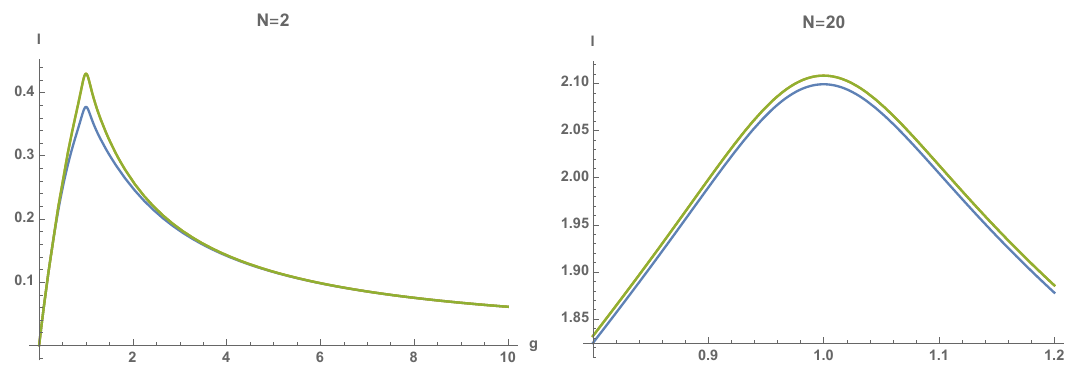
Figure 7. In the above (cid:12)gures the blue and green lines respectively denote the modular invariant interpolating functions for the cusp anomalous dimension ((cid:0) cusp ( (cid:21) )) with zero and non-zero value of the non-planar term (cid:0) np . The non-planar correction decreases with increasing N and hence the maximum di(cid:11)erence is visible at N = 2 and g = 1. The same is plotted for N = 20 zooming around g = 1, which shows a decrease in the di(cid:11)erence with increasing N